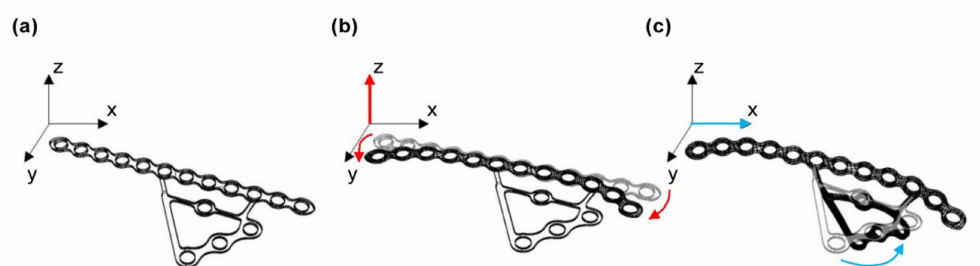
Figure 1. Patient-adapted plate geometry generation through extrusion ( a ), on-plane bending along the z-axis, shown in red ( b ) and off-plane bending along the x-axis, shown in blue ( c ).